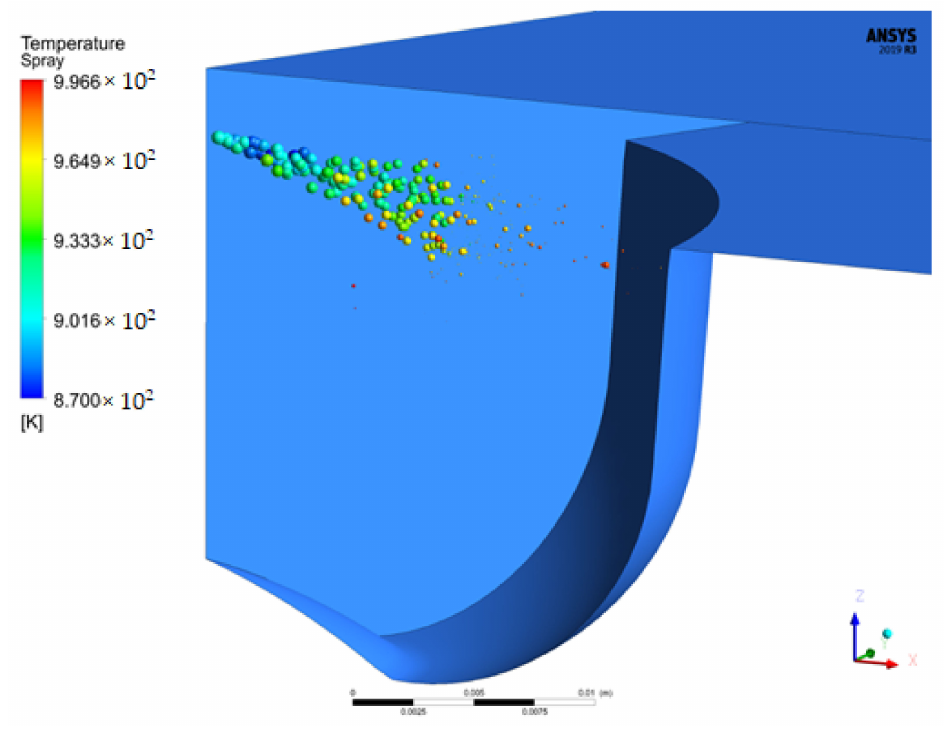
Figure 11. Spray of Biodiesel.